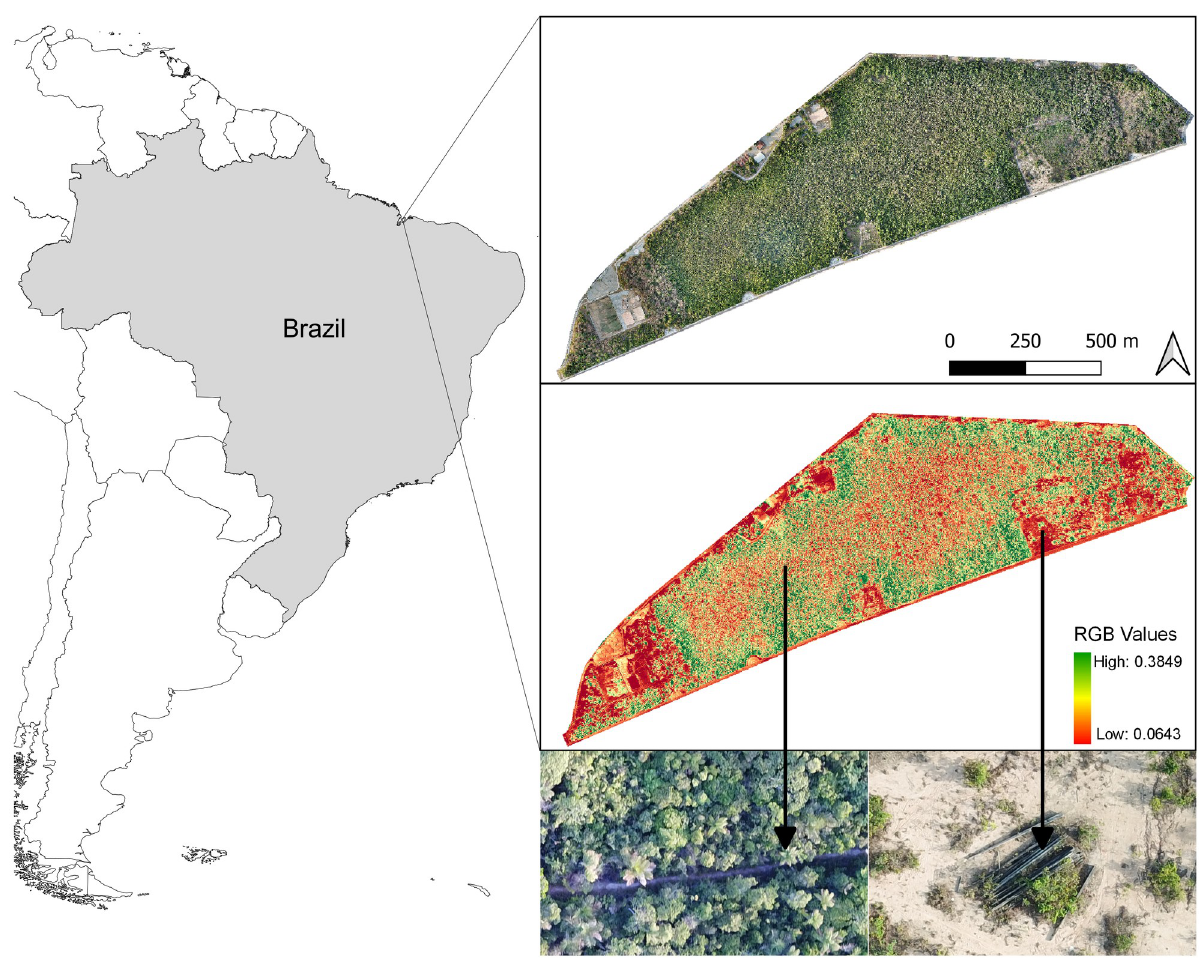
Fig 6. Georeferenced orthomosaic and health vegetation map. Images with a 20x zoom of an open trail in the vegetation and a deforestation area with some irregular